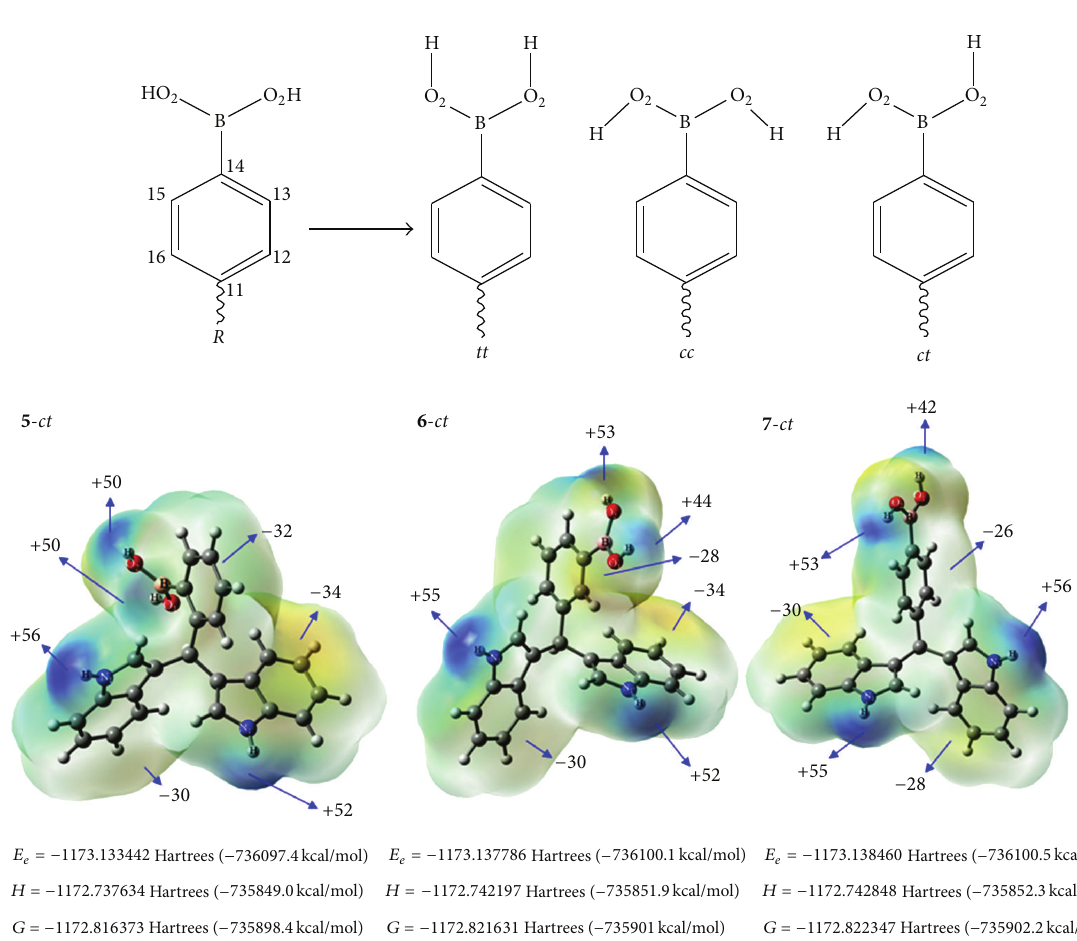
Figure 4: Optimized geometries (electronic, enthalpy, and Gibbs free energy, described in Hartrees and kcal/mol) for the three lowest energy conformers: 5 - ct ( ortho) , 6 - ct ( meta), and 7 -ct (para) . MESPs of 5 - ct , 6 - ct, and 7 - ct showing the minima ( V min : negative) and maxima ( V max : positive) of electron densities, in kcal/mol. All calculations were obtained by DFT calculations at the B3 LYP/6-311++G ∗∗ level.